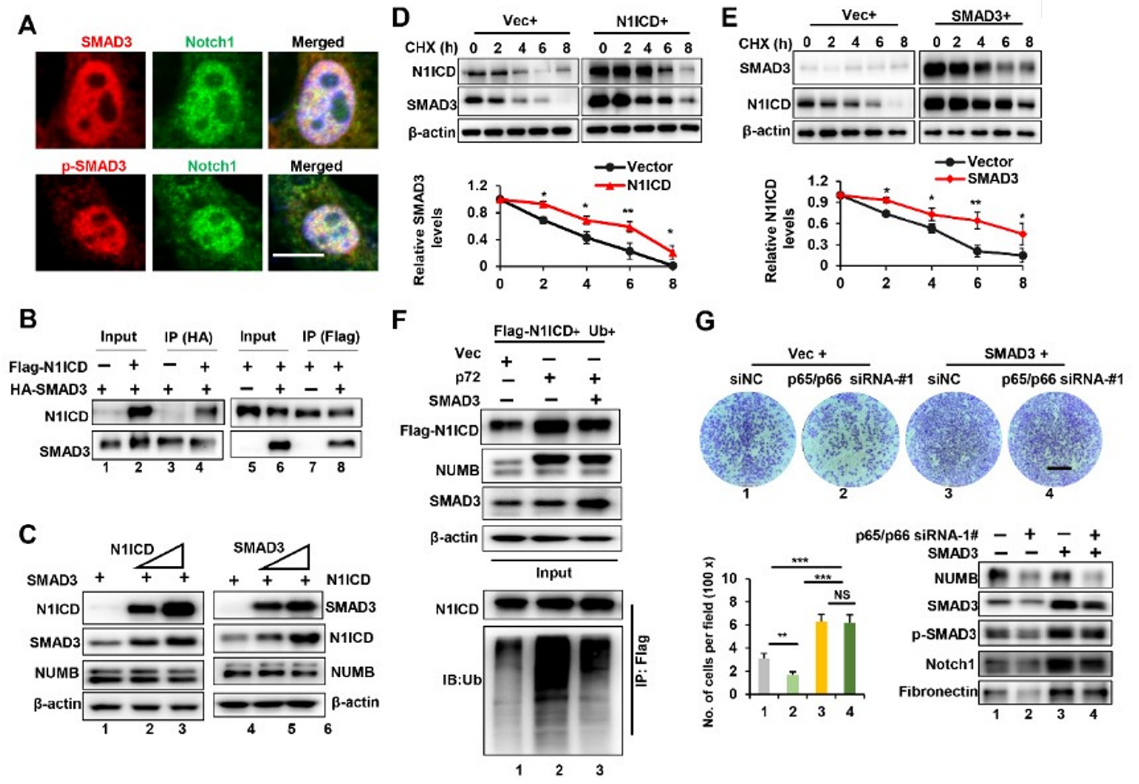
Figure 7. Notch1 and SMAD3 interactions medicated NUMB-induced EMT and cancer cell migration. ( A ) HeLa cells were transfected with the N1ICD expression plasmid, following by immunostaining with indicated antibodies. Representative confocal images are shown. Scale bar is 10 µ m. ( B ) 293T cells were co-transfected with HA-SMAD3, Flag-N1ICD expression plasmids or control vector, as indicated. Whole-cell lysates were extracted and immunoprecipitated with anti-HA antibodies (lanes 1–4) or anti-Flag antibodies (lanes 5–8), followed by Western blot analysis. ( C ) 293T cells were co-transfected with a HA-SMAD3-expression plasmid and increasing amounts of Flag-N1ICD expression plasmids (lanes 1–3), or with a Flag-N1ICD expression plasmid and increasing amounts of HA-SMAD3 expression plasmids (lanes 4–6). Whole-cell lysates were extracted and subjected to Western blotting with indicated antibodies. Overall, 10% of whole cell lysates were used as input. ( D ) 293T cells were transiently transfected with the N1ICD expression plasmid for 48 h, followed by the addition of cycloheximide (CHX, 50 µ g/mL), and Western blotting analysis. Quantification of SMAD3 proteins is shown at the bottom. ( E ) 293T cells were transiently transfected with the SMAD3 expression plasmid for 48 h, followed by the addition of cycloheximide (CHX, 50 µ g/mL) and Western blotting analysis. Quantification of N1ICD proteins is shown at the bottom. ( F ) 293T cells were transiently co-transfected with indicated plasmids for 48 h. Whole-cell lysates were extracted and immunoprecipitated with anti-Flag antibodies followed by Western blotting analysis. Overall, 10% of whole cell lysates were used as input. ( G ) HeLa cells were co-transfected with p65/p66 siRNA-#1 and a SMAD3-expression plasmid, followed by the cell migration assay. Representative images of migratory cells stained with crystal violet were shown on the top. Scale bar is 360 µ m. Quantification of migratory cells as mean ± SD was shown on the left bottom. Western blot analysis was shown on the right bottom. * p < 0.05, ** p < 0.01, *** p < 0.001, NS p > 0.05. As SMAD3 could stabilize N1ICD, next, we asked whether the overexpression of SMAD3 could prevent the p71/p72-mediated ubiquitination of N1ICD. To this end, we co-transfected 293T cells with Flag-N1ICD, Ub, SMAD3 and p72-expression plasmids.